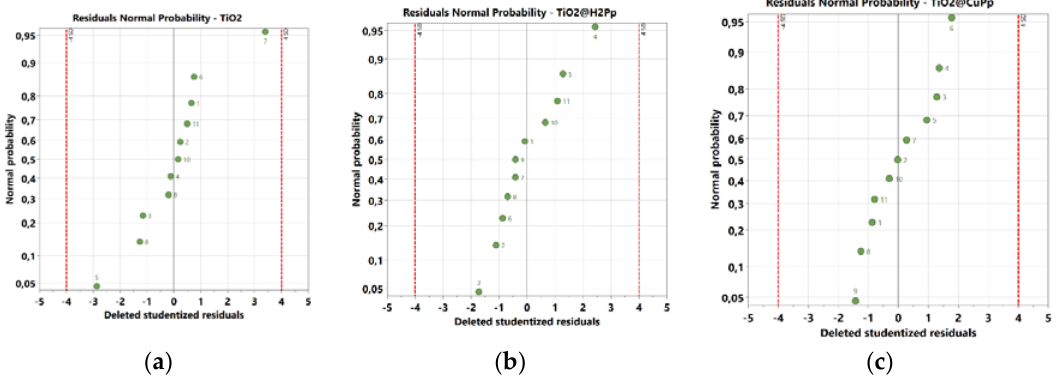
Figure 4. Plot of residuals obtained for the ( a ) TiO 2 , ( b ) TiO 2 @H 2 Pp, and ( c ) TiO 2 @Cu(II)Pp catalysts.